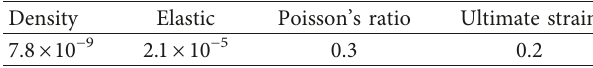
Table 1: Performance parameters of steel materials.